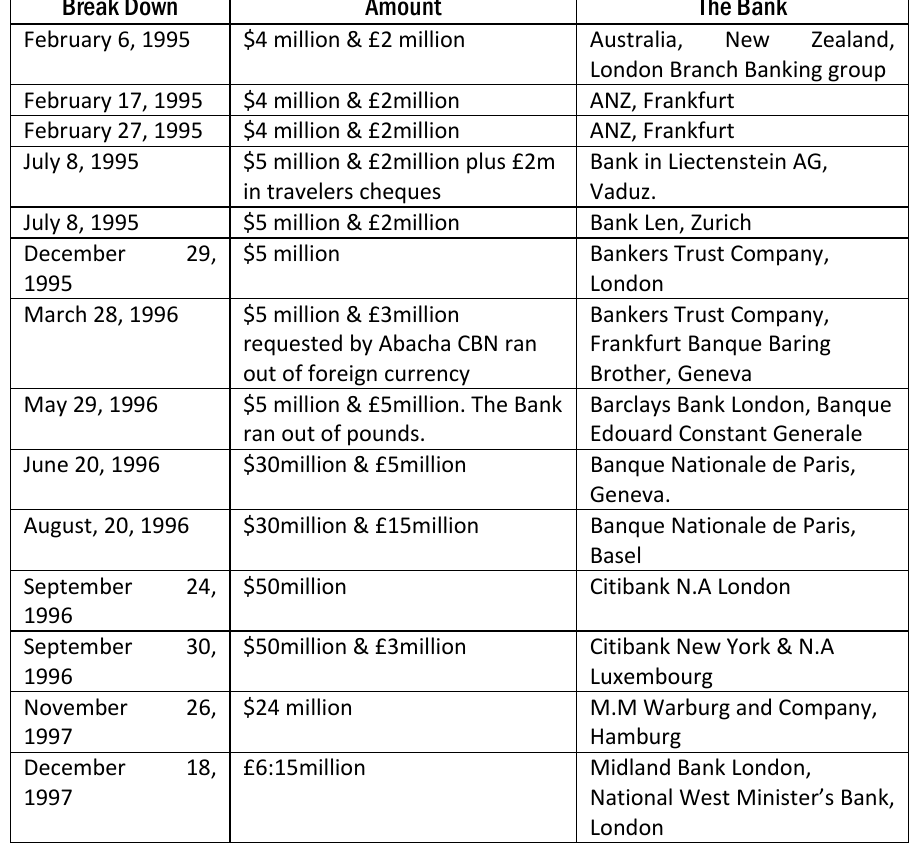
TABLE 2: Abacha’s Loot from the Nigerian